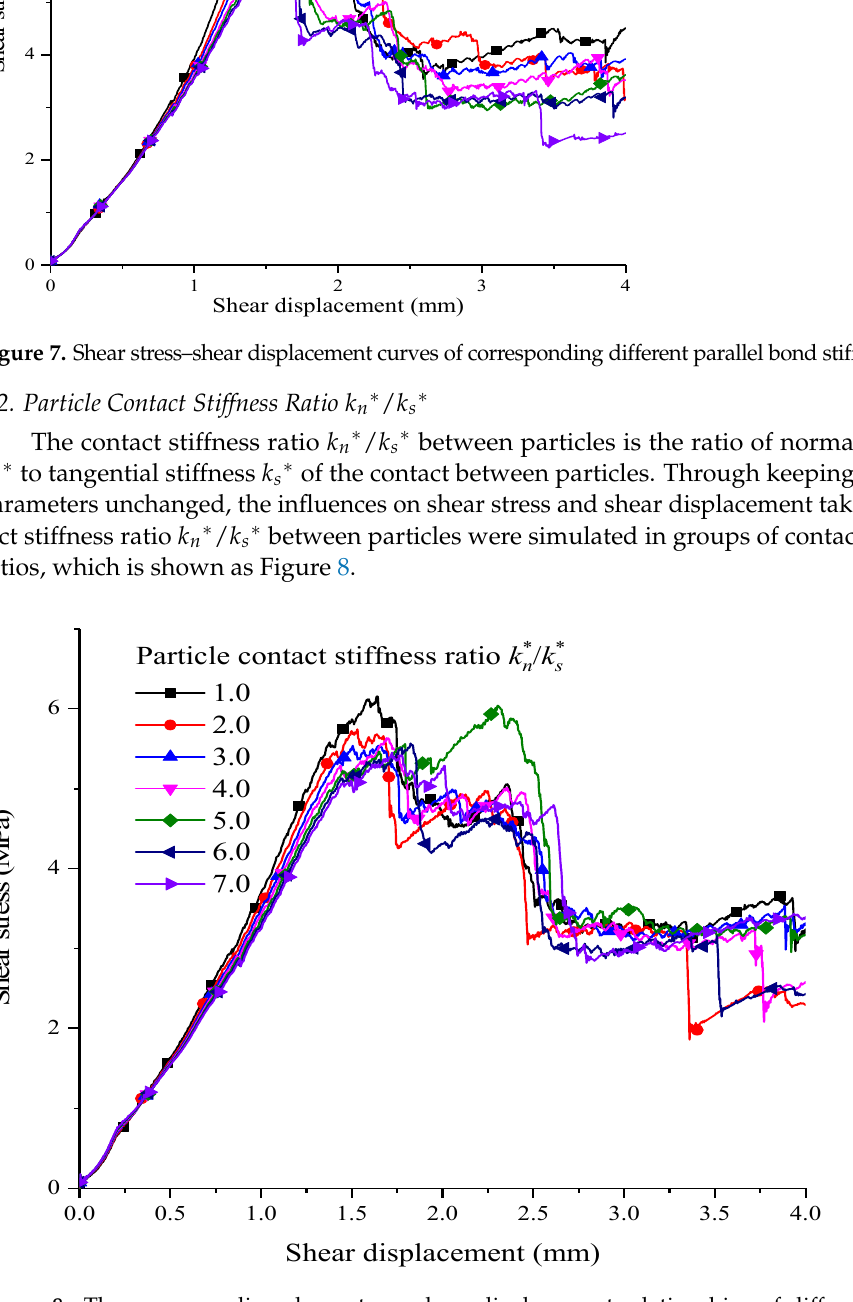
Figure 8. The corresponding shear stress–shear displacement relationships of different particle contact stiffness ratios.